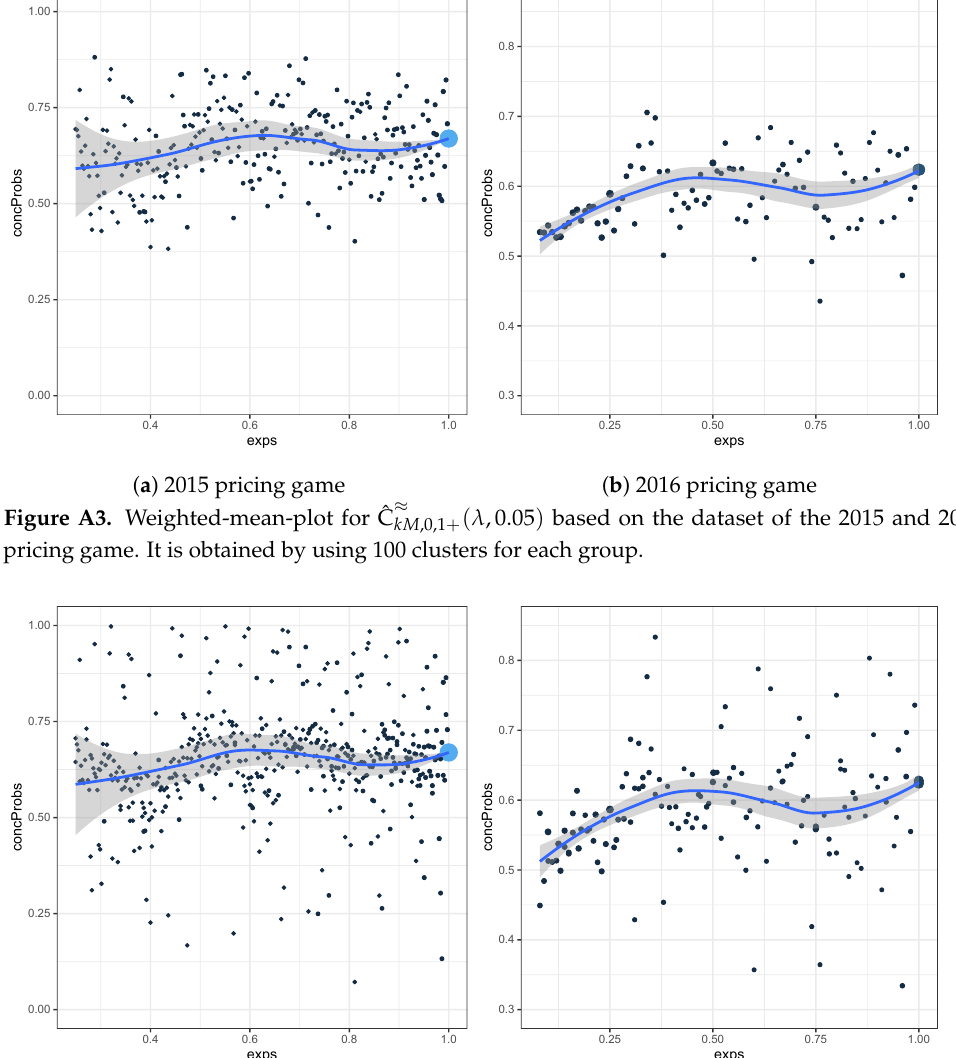
≈ ( λ ,0.05 ) based on the dataset of the 2015 and 2016 ep , kM ,0,1 +